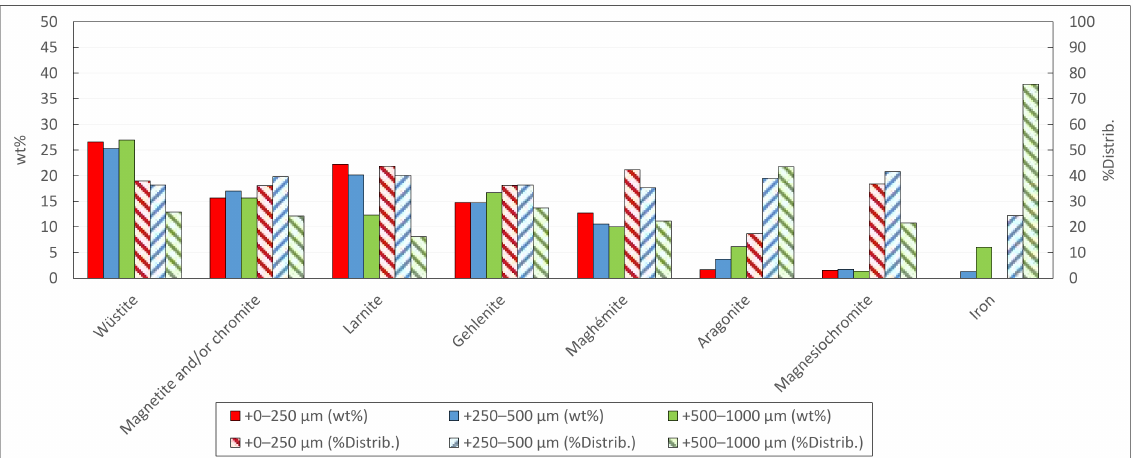
Figure 9. Mineral phases content and distribution in the size fractions +0–250 µ m, +250–500 µ m and +500–1000 µ m after attrition of the magnetic fraction during 40